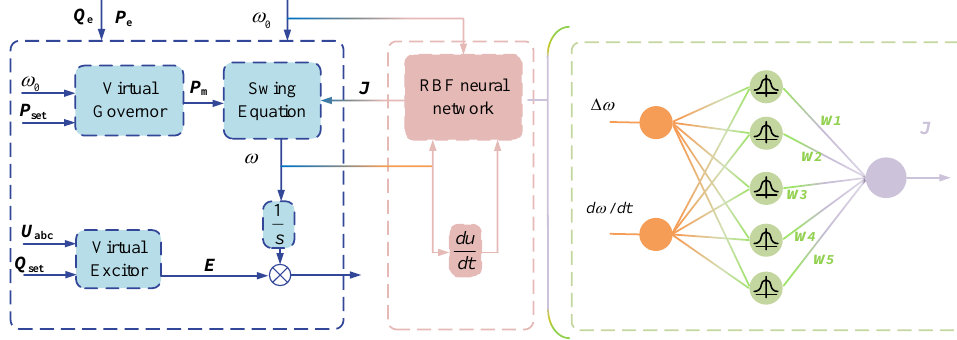
Figure 3. Structural diagram of RBF adaptive virtual synchronous generator.